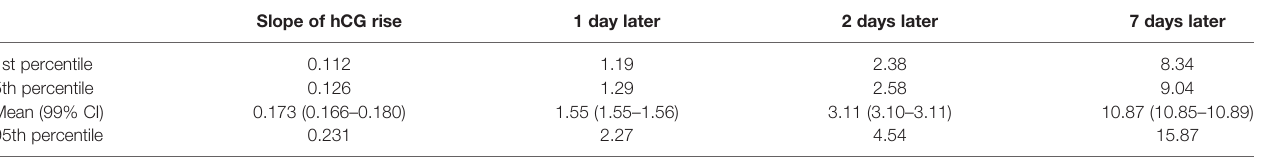
TABLE 2 | Predicted relative increase in hCG levels over time.